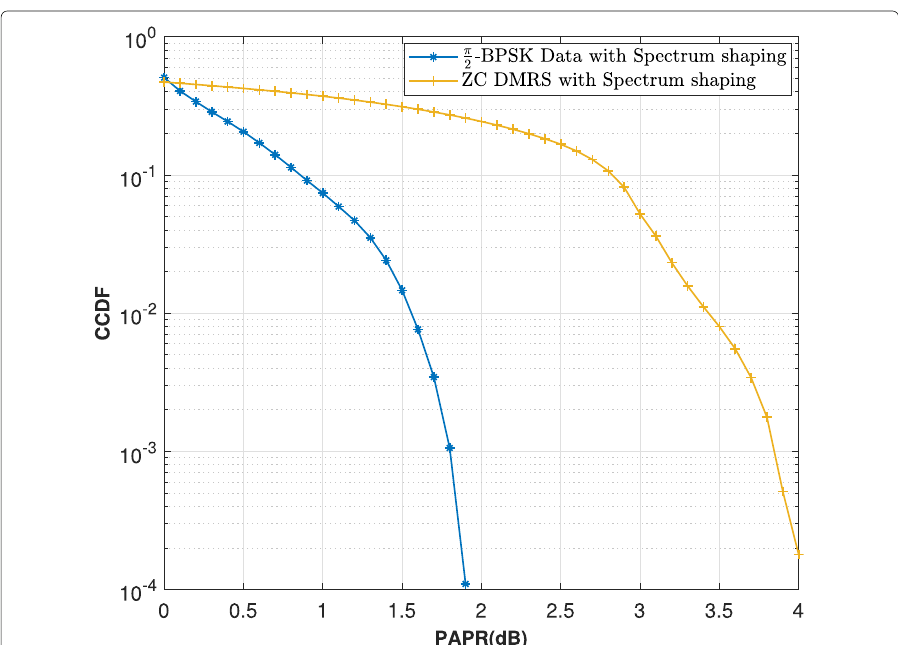
Fig. 2 PAPR comparison between spectrum-shaped ZC sequence and spectrum-shaped π/ 2-BPSK